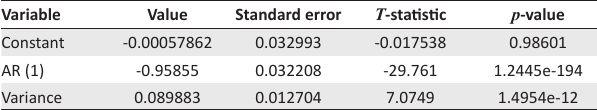
ARIMA (1, 2, 0) Model (Gaussian